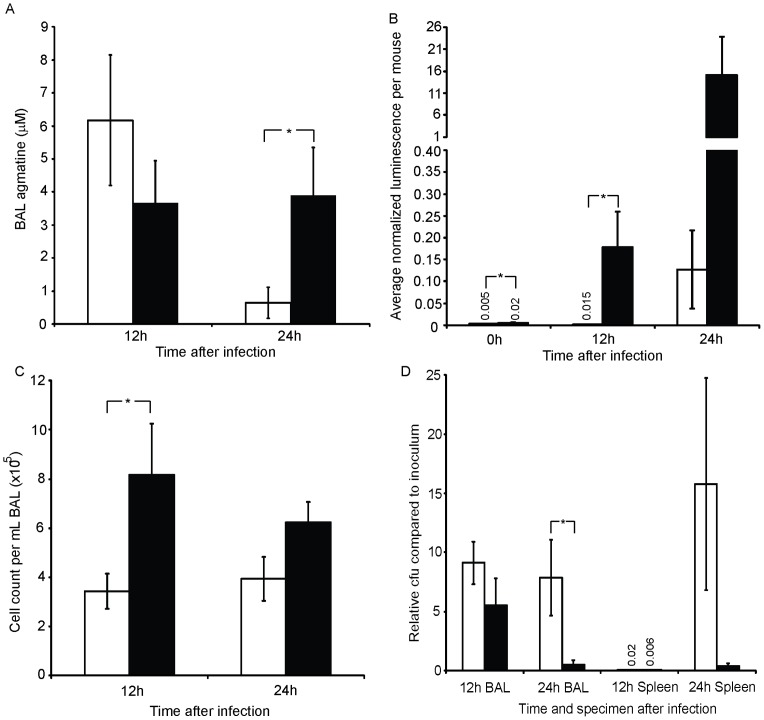
Bacterial agmatine secretion alters inflammation and bacterial survival.
P. aeruginosa strain PA14 (unfilled bars), and an agmatine metabolism mutant (filled bars, aguA::gm, Δagu2ABCA') were injected at 1×106 cfu per mouse. Both harbored the aguR-B:lux reporter system. 10 mice injected per group per timepoint. The agmatine metabolism mutant strain hypersecretes agmatine similarly to the clinical isolates shown in Figure 2. In (A), the average BAL agmatine, as measured by UPLC-MS/MS, is plotted for both groups at each timepoint. In (B) the bacterial luminescence during infections was measured as an indicator of in vivo agmatine secretion/detection by the bacterial aguR:lux system. The luminescence is normalized to the cfu count obtained shortly after imaging. At the times indicated mice were sacrificed for bronchoalveolar lavage and spleen removal for measurement of inflammatory cell count (C), and bacterial cfu counting (D). All error bars represent SEM. Independent t-tests used between groups. *P<0.05.